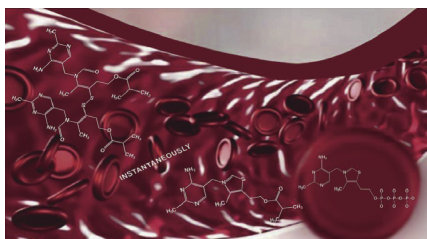
Figure 2: Sulbutiamine transformation in the body. Molecule at left, sulbutiamine; center molecule, O-isobutyryl-thiamine; white inside red blood cell, thiamine triphosphate. ∗ As genuine sulbu- tiamine was never detected in the blood after oral or intravenous administration, its transformation must be very